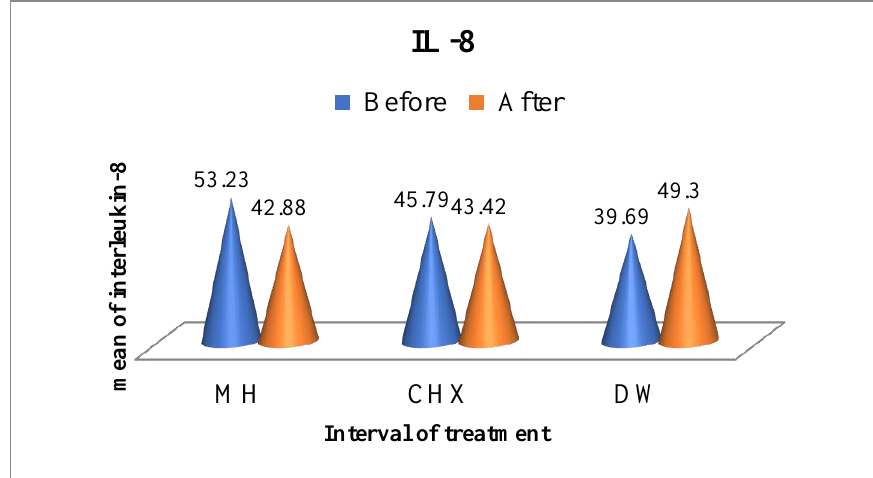
Figure 2: Mean values of IL-8 in study groups before and after mouthwash use.